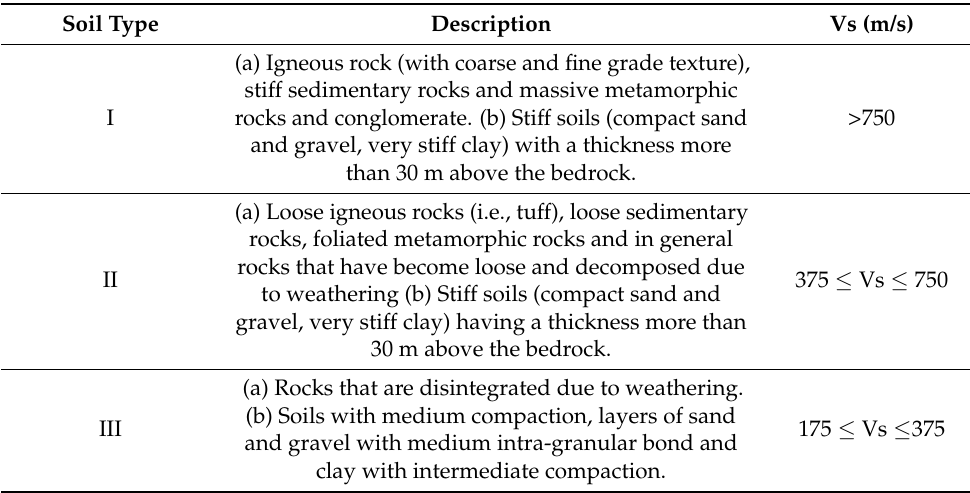
Table 2. Soil profile classification based on the Iranian Code of Practice for the Seismic Resistant Design of Buildings: Standard No. 2800